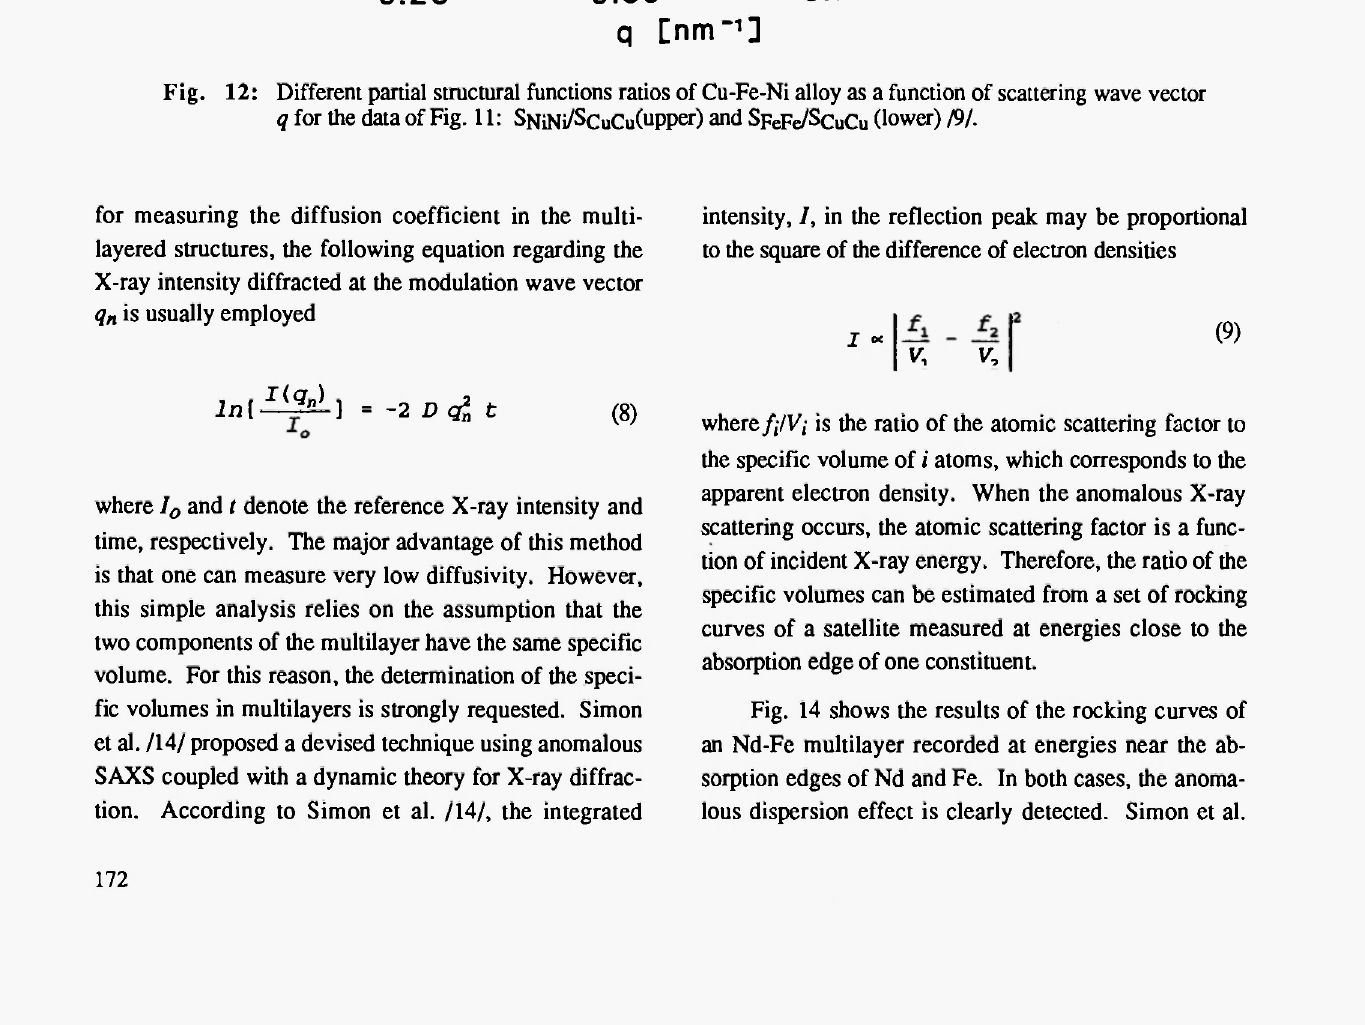
Fig. 12: Different partial structural functions ratios of Cu-Fe-Ni alloy as a function of scattering wave vector q for the data of Fig. 11: SNiNi/SCuCu (upper) and SpeFe/SCuCu (lower)